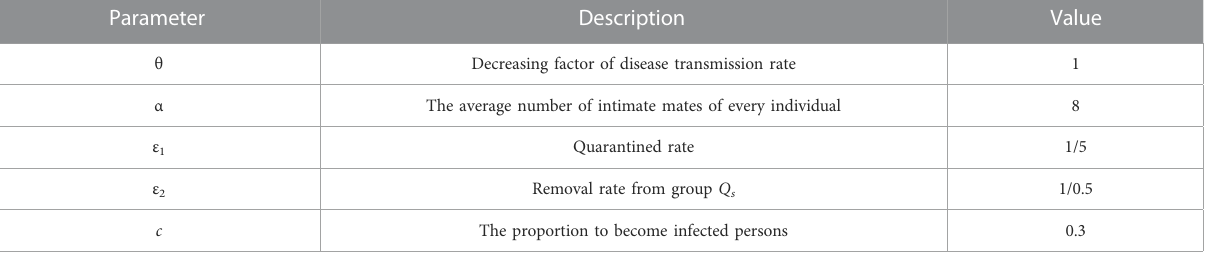
TABLE 4 Parameter description and value of control model with non-pharmaceutical interventions.